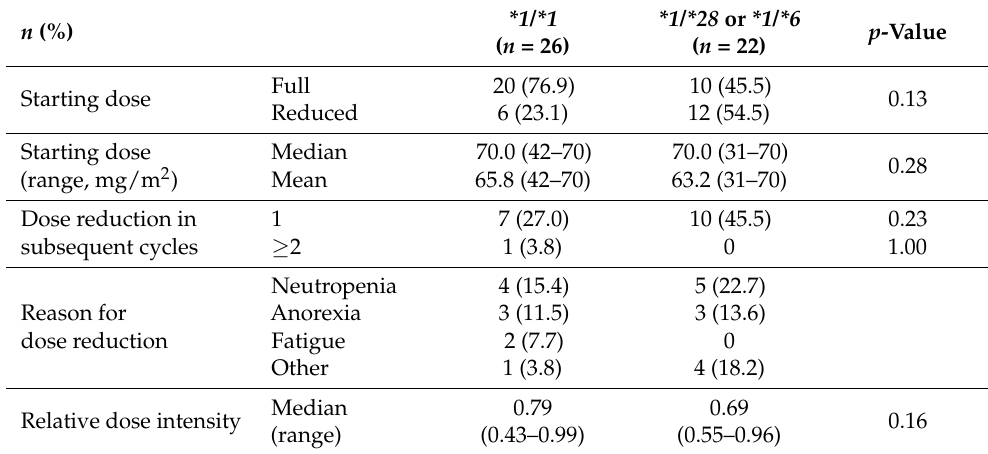
Table 4. Treatment details for nal-IRI according to UGT1A1